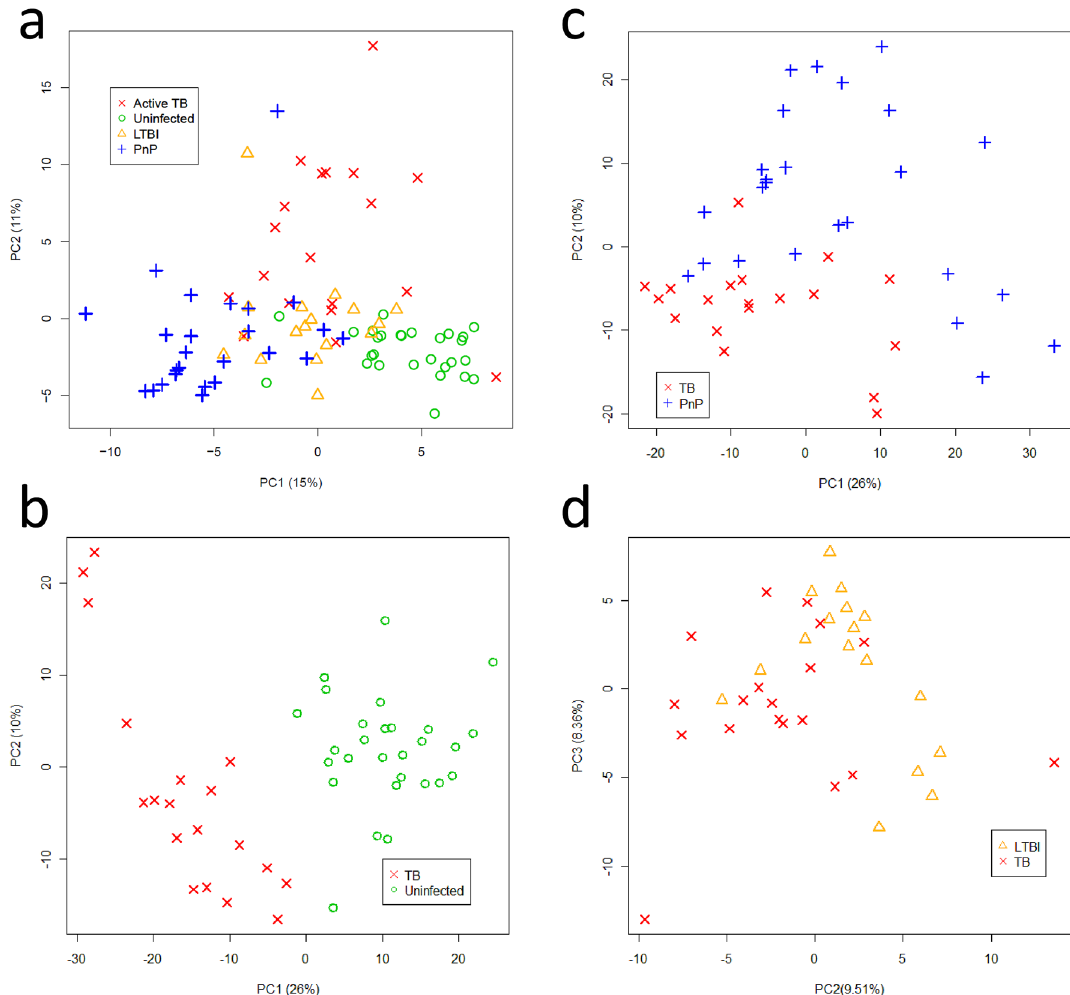
Figure 2. Principal Component Analysis (PCA) score plots of urine spectra analyzed by high-field Nuclear Magnetic Resonance of ( a ) untreated TB patients (n = 19), uninfected individuals (n = 28), pneumococcal pneumonia patients (n = 25) and LTBI individuals (n = 17); ( b ) untreated TB and uninfected individuals; ( c ) untreated TB and pneumococcal pneumonia patients; ( d ) untreated TB and LTBI individuals. TB, tuberculosis; PnP, pneumococcal pneumonia; LTBI: latent TB infection; PC, Principal